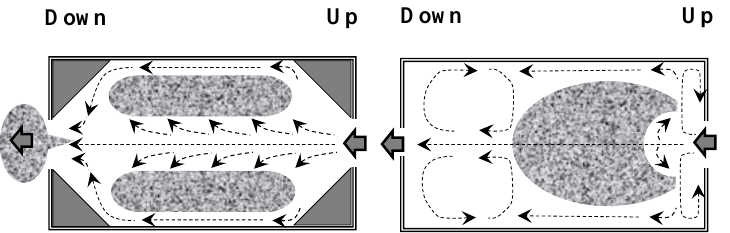
Figure 12. Effect of shape changes in the sediment basin on the flow conditions and containment ( Left : with corners; right : without corners).